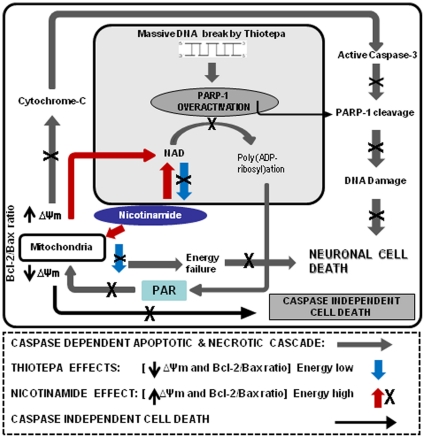
A schematic diagram representing the hypothetical mechanism by which nicotinamide protects against thiotepa-induced neurodegeneration in the brain of the developing rat.Thiotepa-induced neurodegeneration is caused by the overactivation of mitochondria-dependent apoptosis, beginning with the down-regulation of Bax, an increase in cytochrome c release from mitochondria to cytosol, expression of activated capase-3, cleavage of PARP-1 and necrosis by overactivation and cleavage of PARP-1 and depletion of NAD+ (blue arrow). PARP-1 activation and formation of Poly ADP-ribose PAR in the nucleus, which translocates to the cytosol to induce caspase-independent cell death (black arrow). Nicotinamide, as indicated by the X sign, inhibits several key elements in the apoptotic cascade beginning with the down-regulation of Bax, a decrease in cytochrome c release from mitochondria to cytosol, inhibition of activated caspase-3 and cleavage of PARP-1 and necrosis by the inhibition of PARP-1 activation and prevention of ATP and NAD+ depletion (red arrow), resulting in protection against thiotepa-induced apoptotic and possible necrotic cell death.